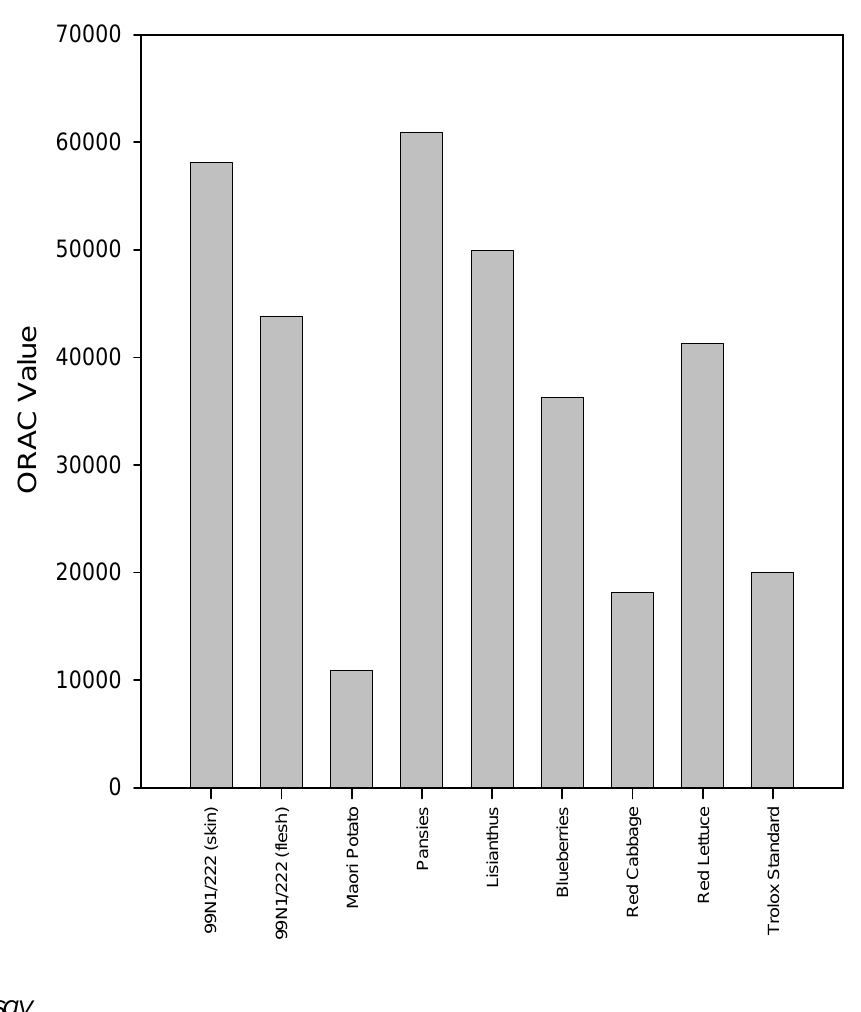
Figure 6 . Bar graph showing ORAC values for each extract from the ORAC assay. The ORAC values represent the efficiency of each extract to inhibit peroxyl radical oxidation, thus R-PE fluorescence, and were calculated from the average of duplicate S values derived from the measurement of